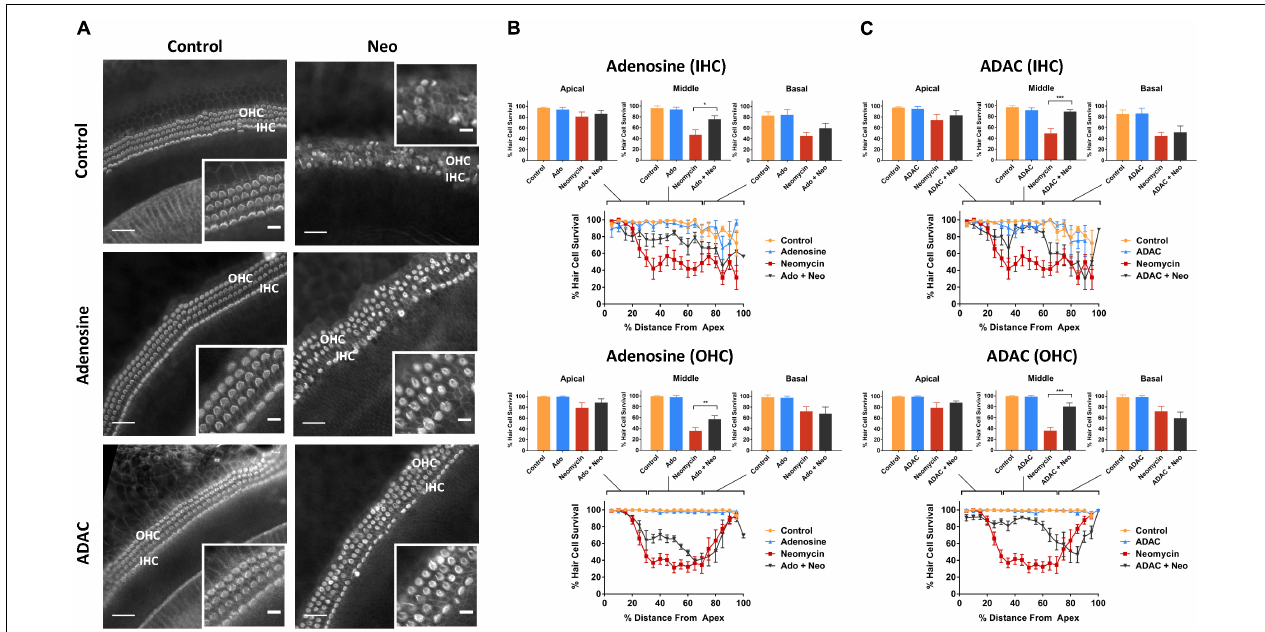
FIGURE 5 | Effect of adenosine or ADAC supplementation on hair cell survival in the neomycin-treated mouse P3 organ of Corti explant. (A) Cochlear explants (middle segment) incubated in normal culture medium enriched with adenosine or ADAC for 42 h with or without neomycin administration (1 mM, 3 h) in the middle of the timeframe. IHCs, inner hair cells; OHCs, outer hair cells. Scale bars: main, 30 µ m; inset, 10 µ m. (B) Adenosine (100 µ M) supplementation significantly improved the survival of IHC ( p < 0.05) and OHC ( p < 0.01, one-way ANOVA) in the middle cochlear turn in the organ of Corti incubated with neomycin. Data presented as mean ± SEM (adenosine, n = 5 and adenosine + neomycin, n = 6). (C) A 1 R agonist ADAC (1 µ M) also improved IHC and OHC survival in the middle turn of the cochlea ( p < 0.001, one-way ANOVA). Data presented as mean ± SEM (ADAC, n = 4 and ADAC + neomycin, n =